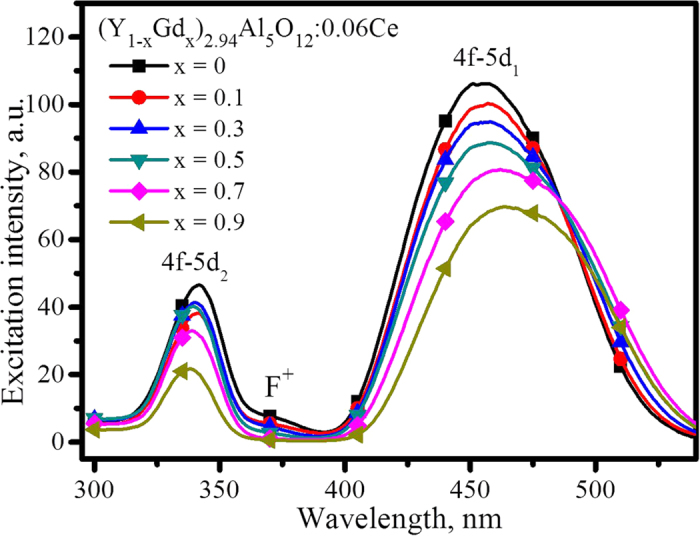
Excitation spectra of (Y1−xGdx)3Al5O12 upon the strongest emission at room temperature.